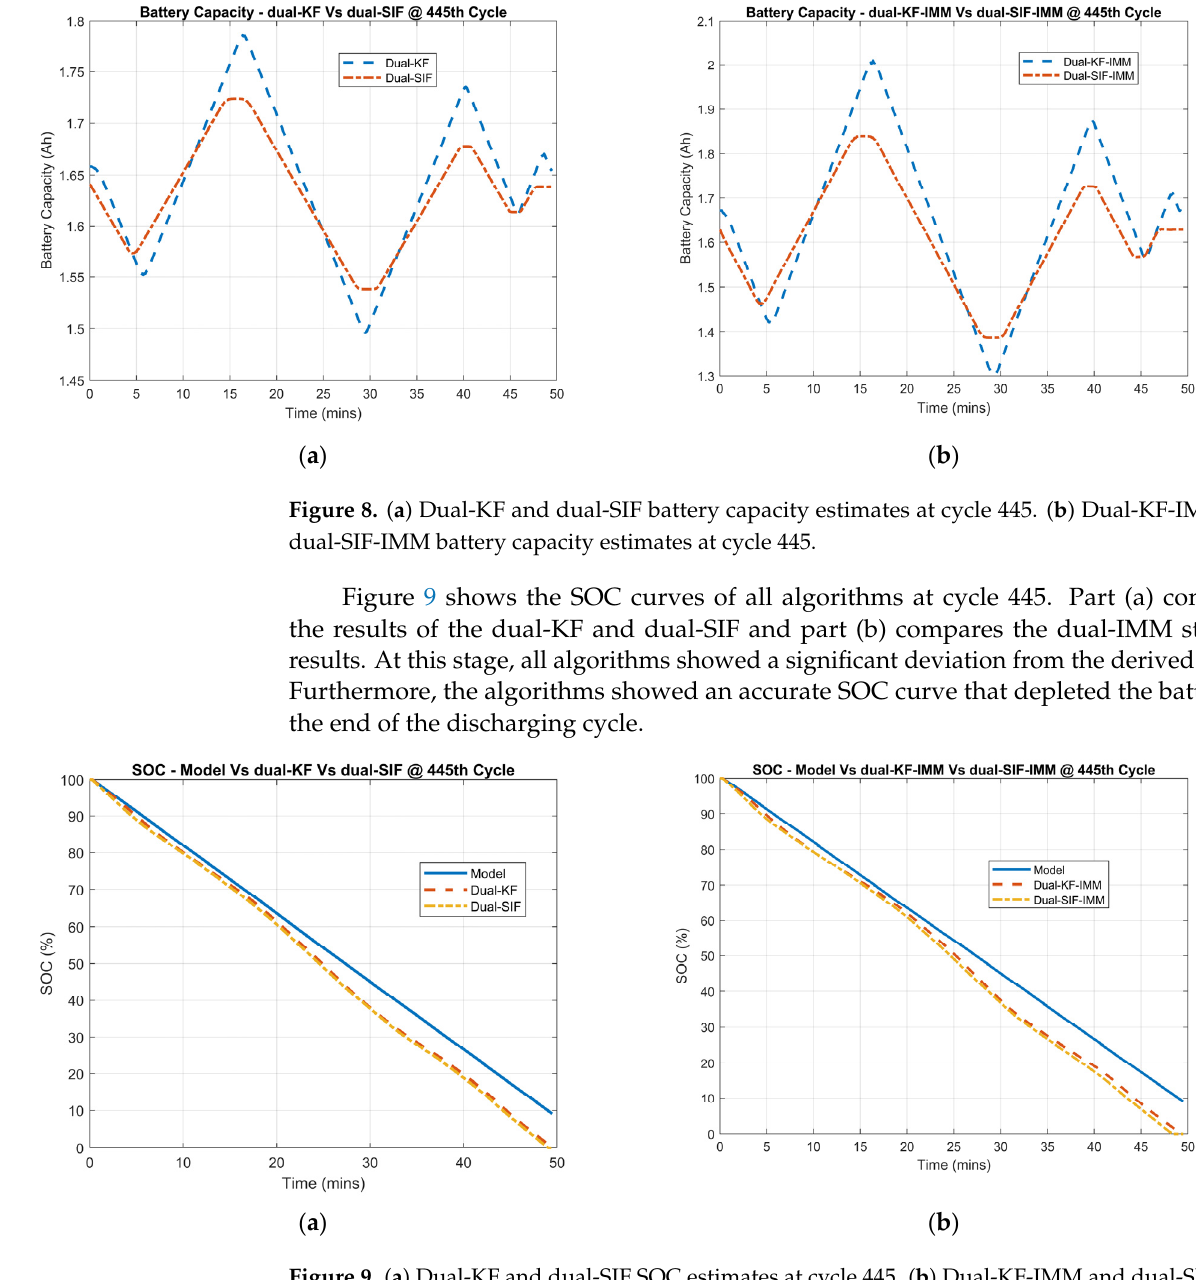
( b ) Figure 7. ( a ) Dual-KF and dual-SIF SOC estimates at cycle 21. ( b ) Dual-KF-IMM and dual-SIF-IMM SOC estimates at cycle 21. Cycle 445 was selected to show the algorithms’ estimation process toward the end of battery life. At this cycle, the battery had a reported battery capacity of 1.6 Ah. Figure 8 illustrates the battery capacity estimates during this cycle. Part (a) compares the results of the dual-KF and dual-SIF and part (b) compares the dual-IMM strategy results. At this stage, all the algorithms showed strong accuracy in tracking the correct battery capacity.